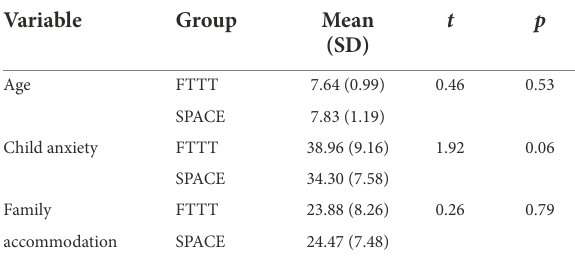
TABLE 6 Comparison of the groups based on age and baseline